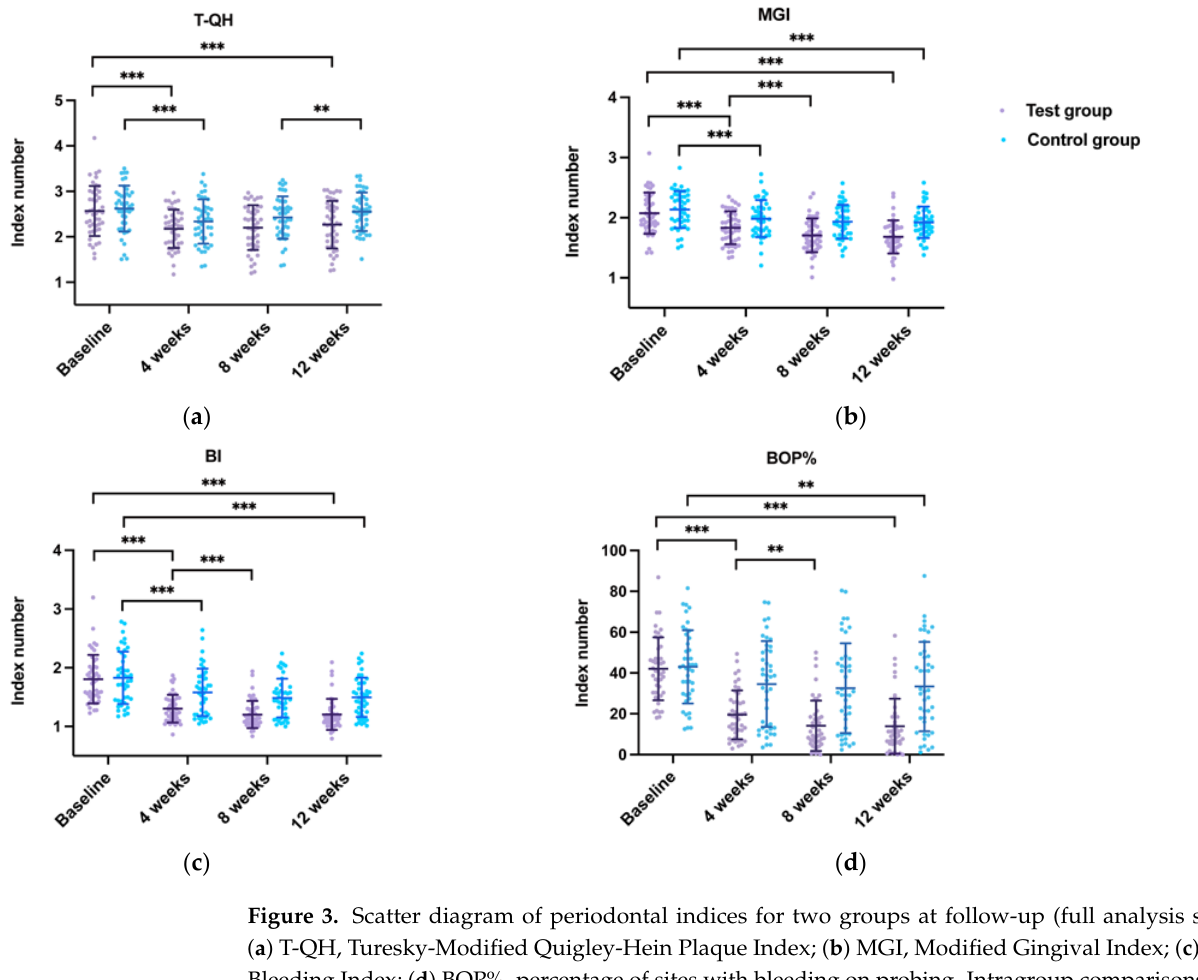
Table 4. Comparison of adverse events between for two groups (safety set).